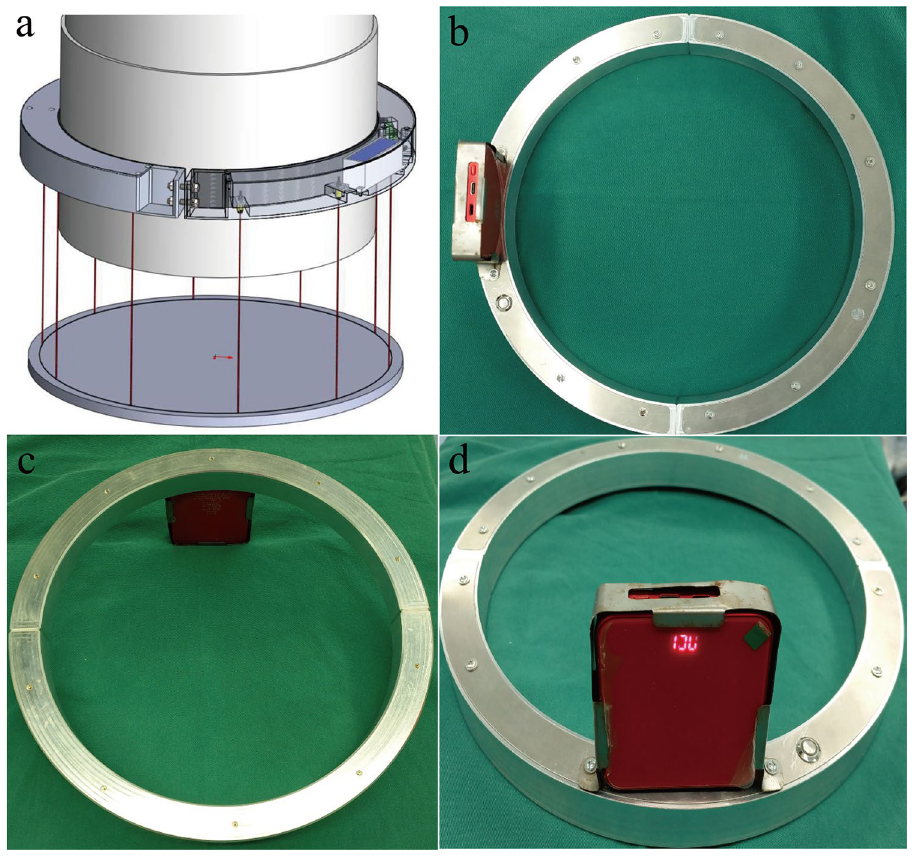
Figure 6. ( a ) Locator mounted on the image intensifier shooting 10 laser lines. ( b ) Top view of the locator. ( c ) Bottom view of the locator. ( d ) Side view of the